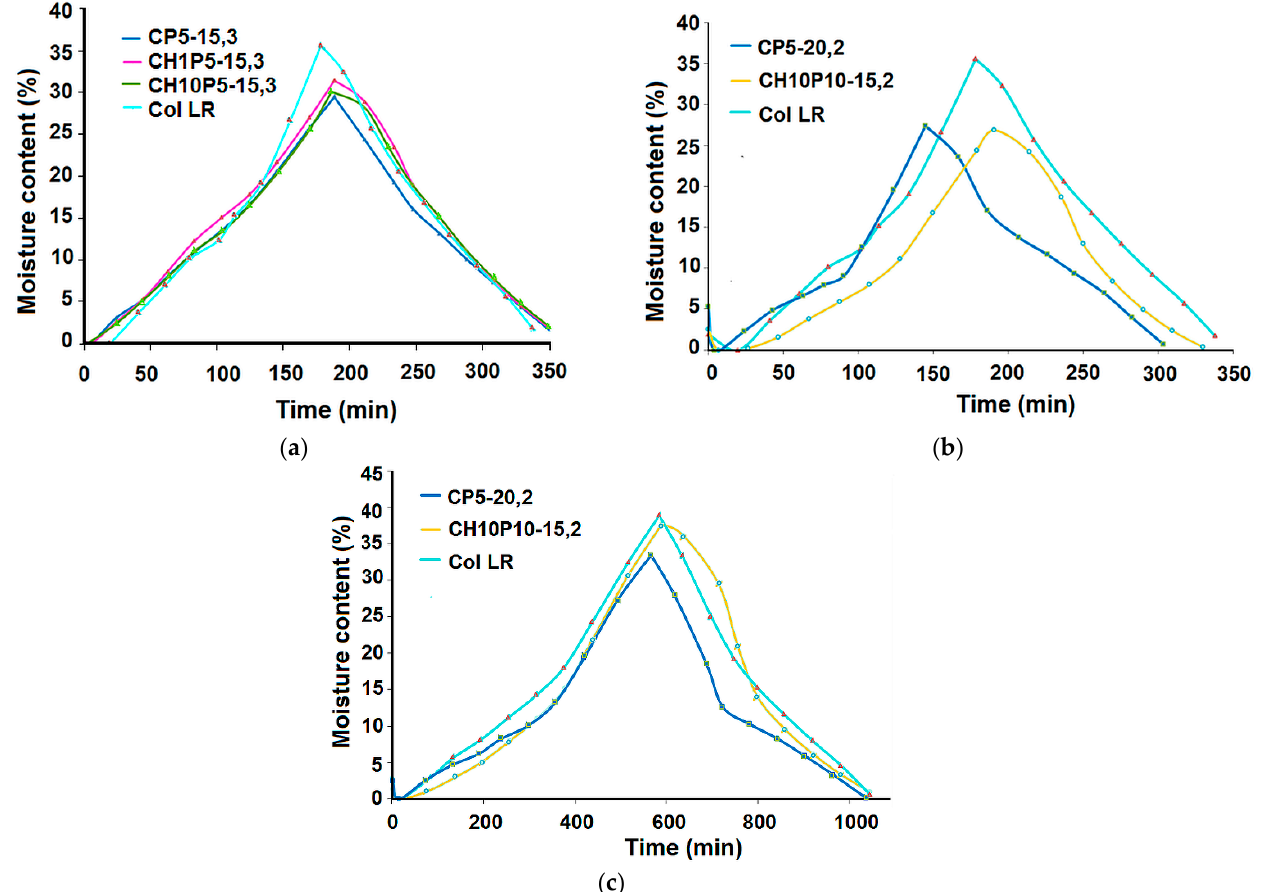
Figure 4. Kinetics of water sorption/desorption for different experimental conditions (equilibrium time): ( a , b ) equilibrium time 10/20 min; ( c ) equilibrium time 40/60 min.